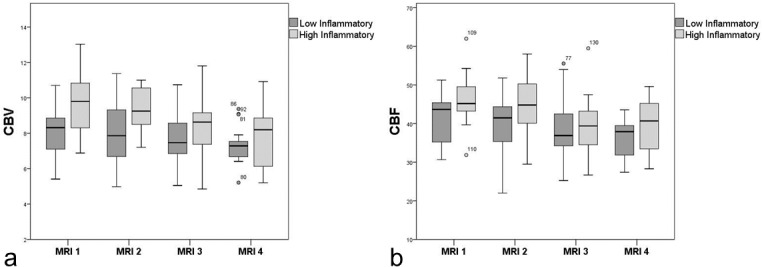
Temporal evolution of perfusion parameters in NAWM comparing high inflammatory with low inflammatory patients: a) CBV, b) CBF.